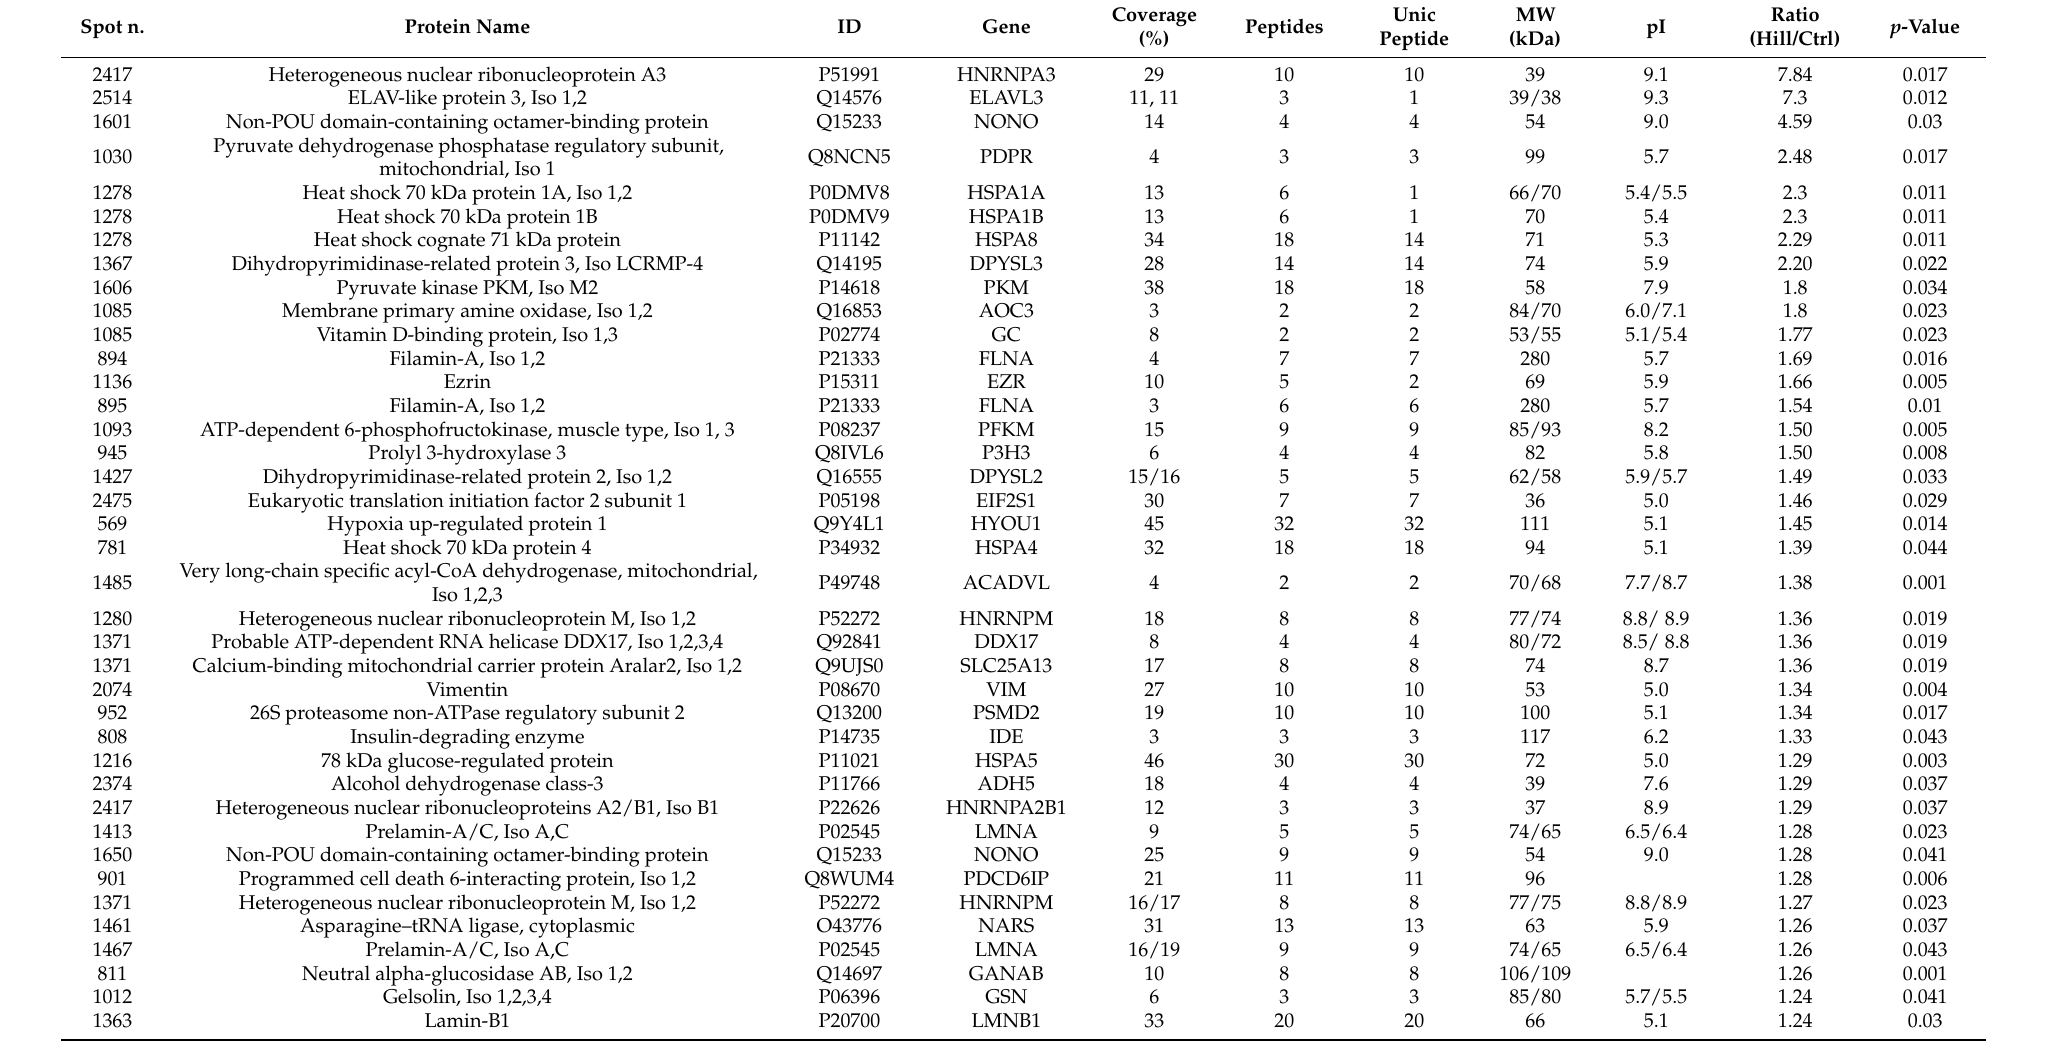
Table 4. List of differentially expressed proteins, which are exclusive of hill extract treated cells. Spot